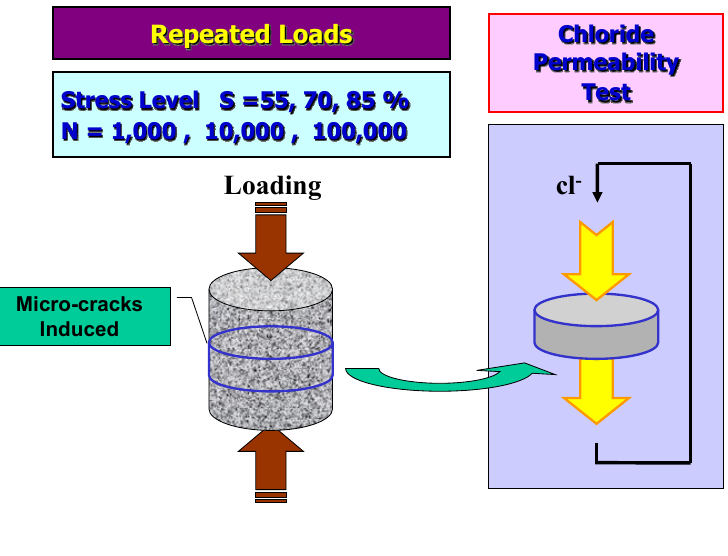
Figure 1. Schematic diagram of this experiment.